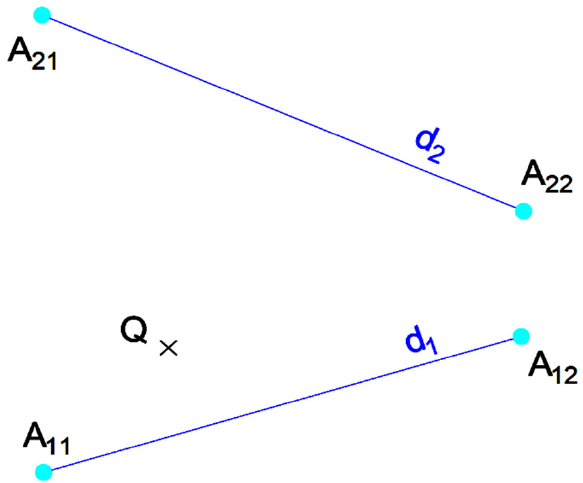
Figure 4. Connecting the point Q to the lines d 1 and d 2 .